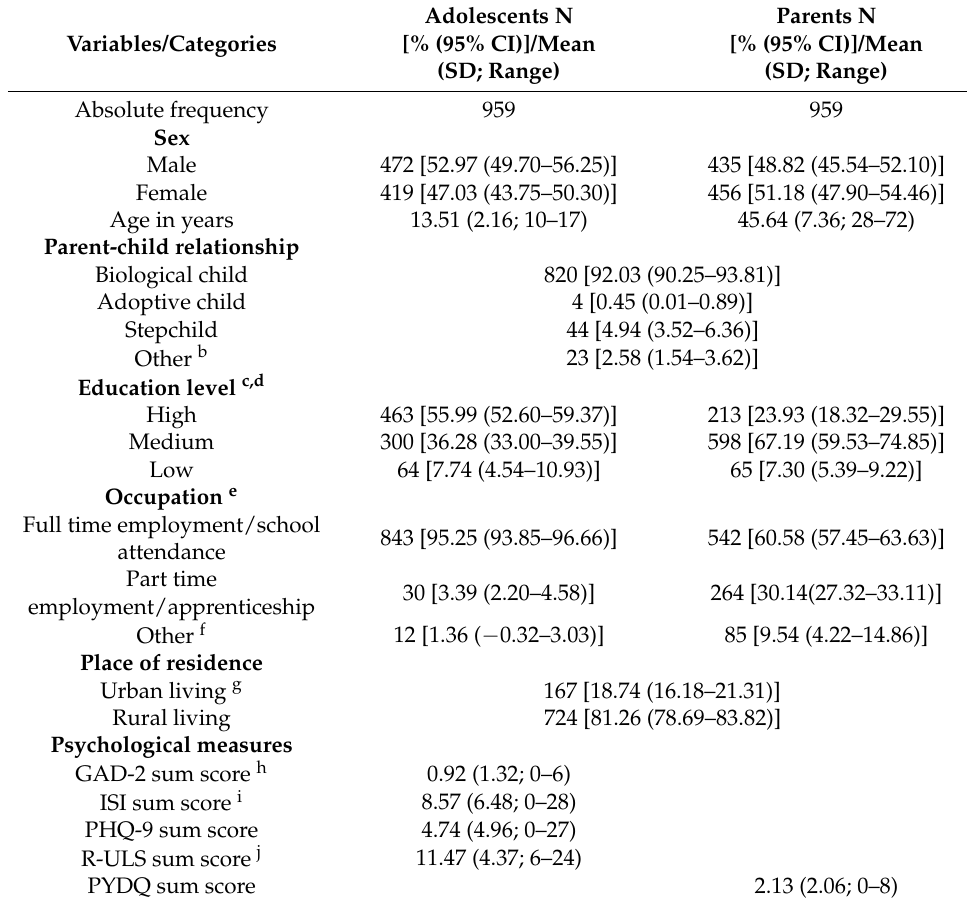
Table 2. Sociodemographic characteristics of final sample a